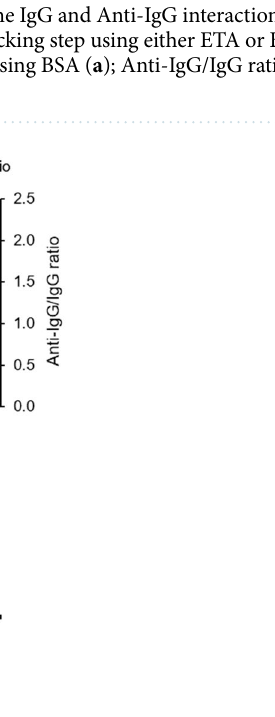
Figure 9. Optical thicknesses of IgG and Anti-IgG interaction on gold surfaces modified with ePDA, in the absence and presence of a blocking step using either ETA and BSA; and with ePDA-ETA film, in the absence and presence of a blocking step using BSA. Anti-IgG/IgG ratios, obtained from three independent ellipsometric assays, are also